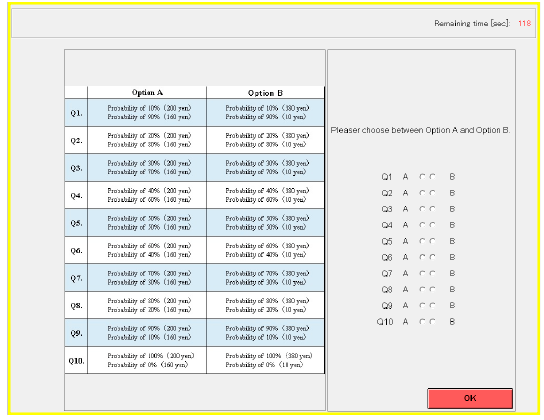
Figure A2. Computer screen for Task 1.